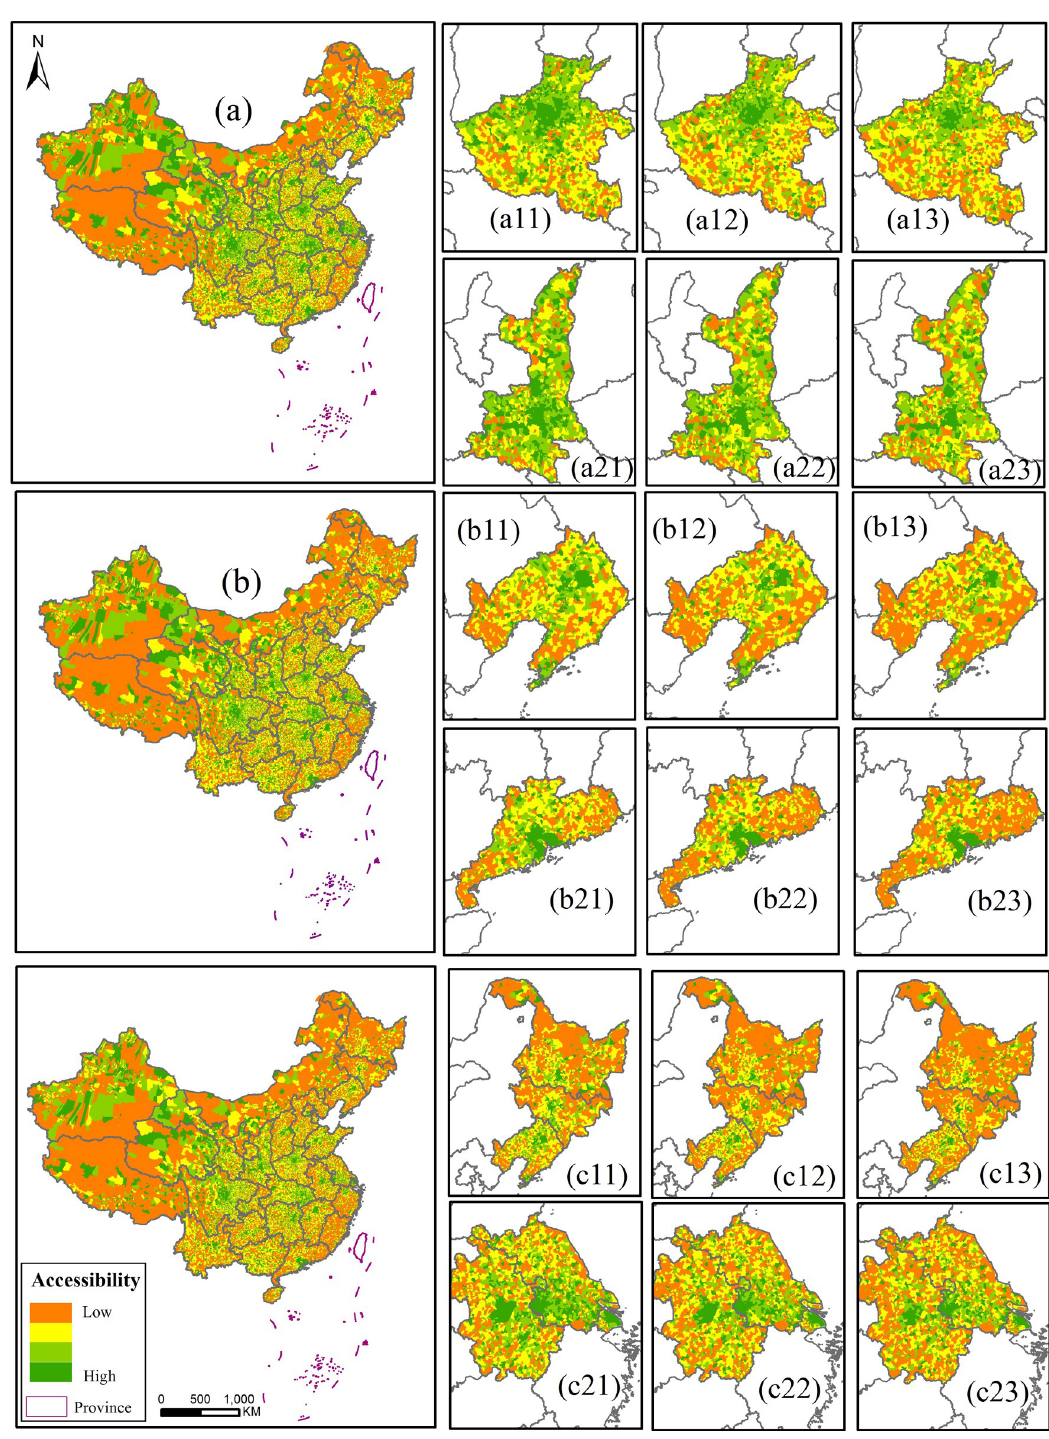
Fig 3. Spatial distribution of residents’ medical accessibility under three scenarios in China. (a) the accessibility under the Business-as-usual scenario; (b) the accessibility under the General public health case scenario;(c) the accessibility under the Major public health case